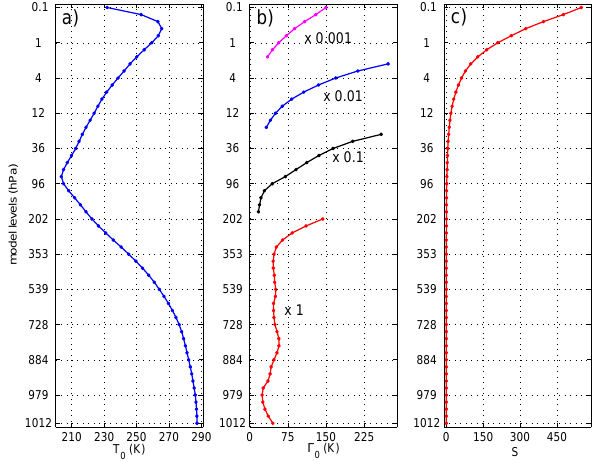
Figure 2. Globally averaged vertical profiles of (a) temperature T 0 , Figure 2. Globally-averaged vertical profiles of (a) temperature, (b) stability Γ 0 and (c) normalized stability parameter S on model levels (b) stability (cid:48) 0 and (c) normalized stability parameter S on model which is input to thevertical structureequation (10). Profiles are based on ERA Interimmodel-level data for year 2000. Labels on y -axis are average pressures of the model levels. Values of stabilityat various levels in (b) are scaled by different factors for clarityreasons. Under 200 levels. The stability profile is input to the vertical structure equa- hPa stabilityis not scaled. tion (10). Profiles are based on ERA Interim model-level data for year 2000. Labels on y axis are average pressures of the model lev- els. Values of stability at various levels in (b) are scaled by different factors for clarity reasons. Under 200hPa stability is not